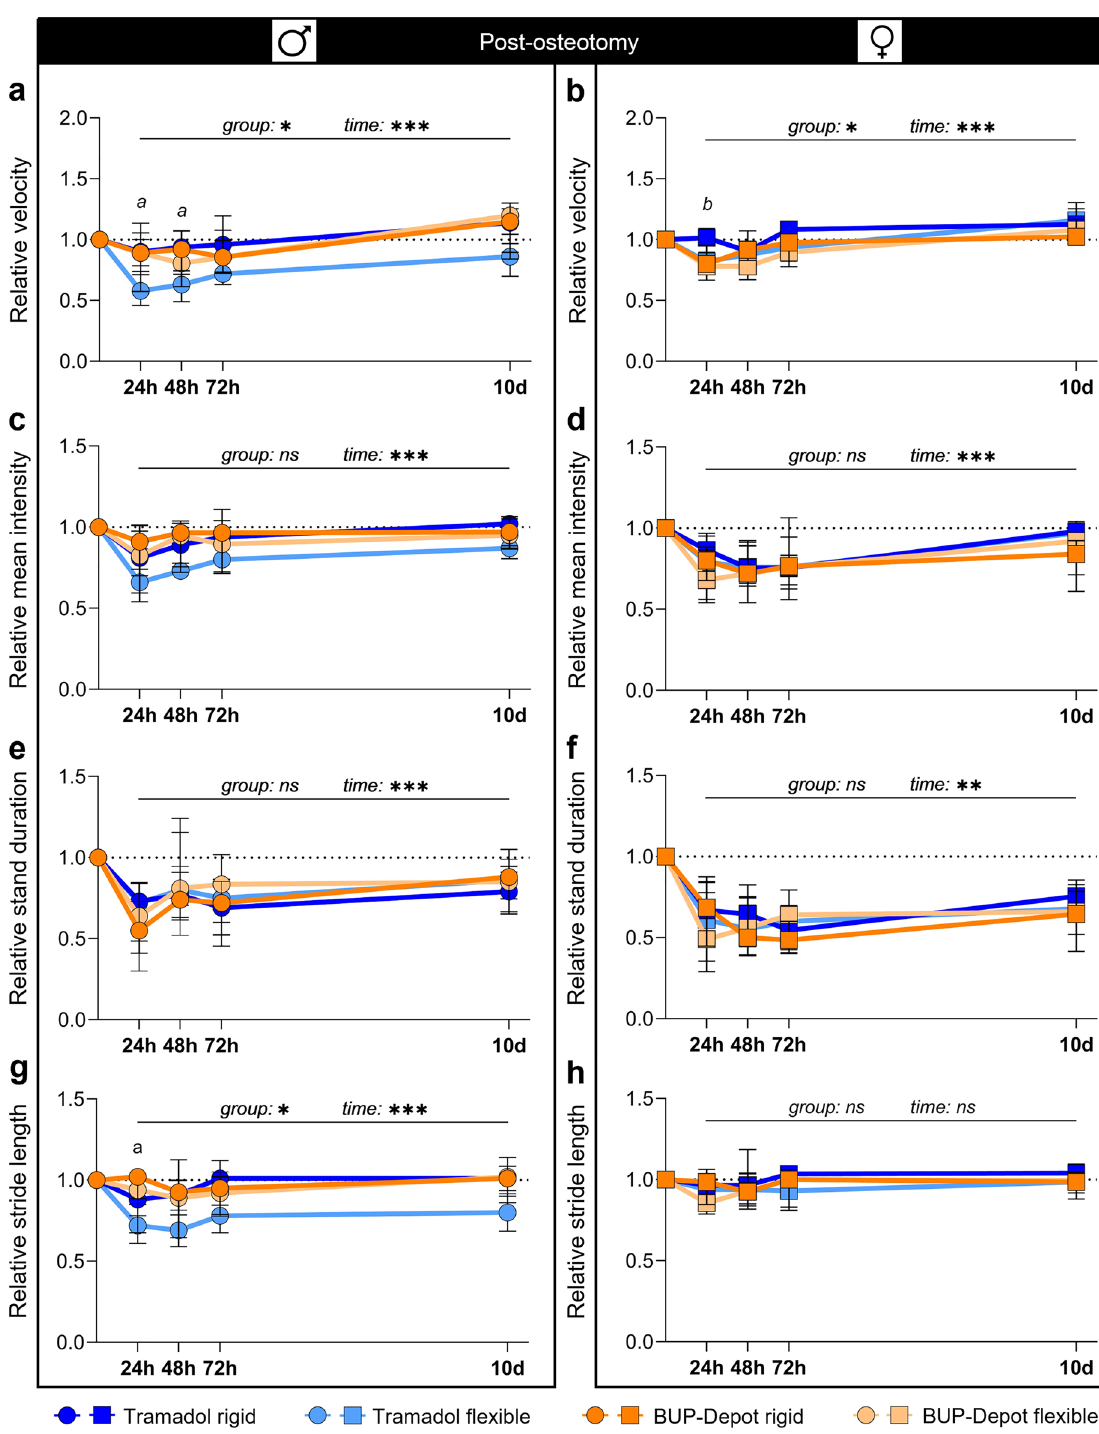
Figure 5. Gait analyses show model-related alterations in walking behavior specifically pronounced in male mice with flexible fixation and Tramadol treatment. CatWalk analysis was conducted at 24 h, 48 h, 72 h and 10 days post-osteotomy and normalized to the initial mean baseline value focusing on ( a,b ) relative velocity, ( c,d ) relative mean intensity, ( e,f ) relative stand duration and ( g,h ) relative stride length. All graphs show median with interquartile range for n = 8–10. Non-parametric ANOVA-type test—main effects of time and of group are represented in the graphs; exact p -values are listed in Table S7–S10.2; * p < 0.05, *** p < 0.001. To determine group differences Kruskal–Wallis test and Dunn’s post hoc test with Bonferroni correction were performed. ( a ) Significant difference Tramadol flexible vs. BUP-Depot rigid; ( b ) significant difference Tramadol rigid vs. BUP- Depot